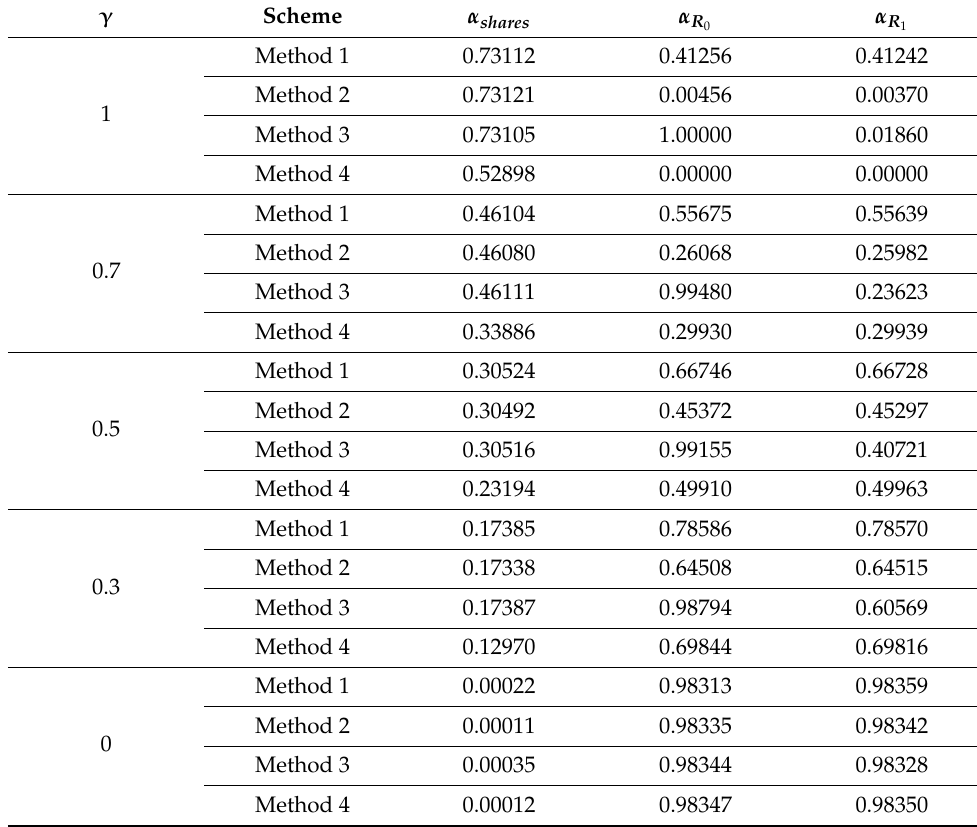
Table 2. The Contrast analysis of the proposed